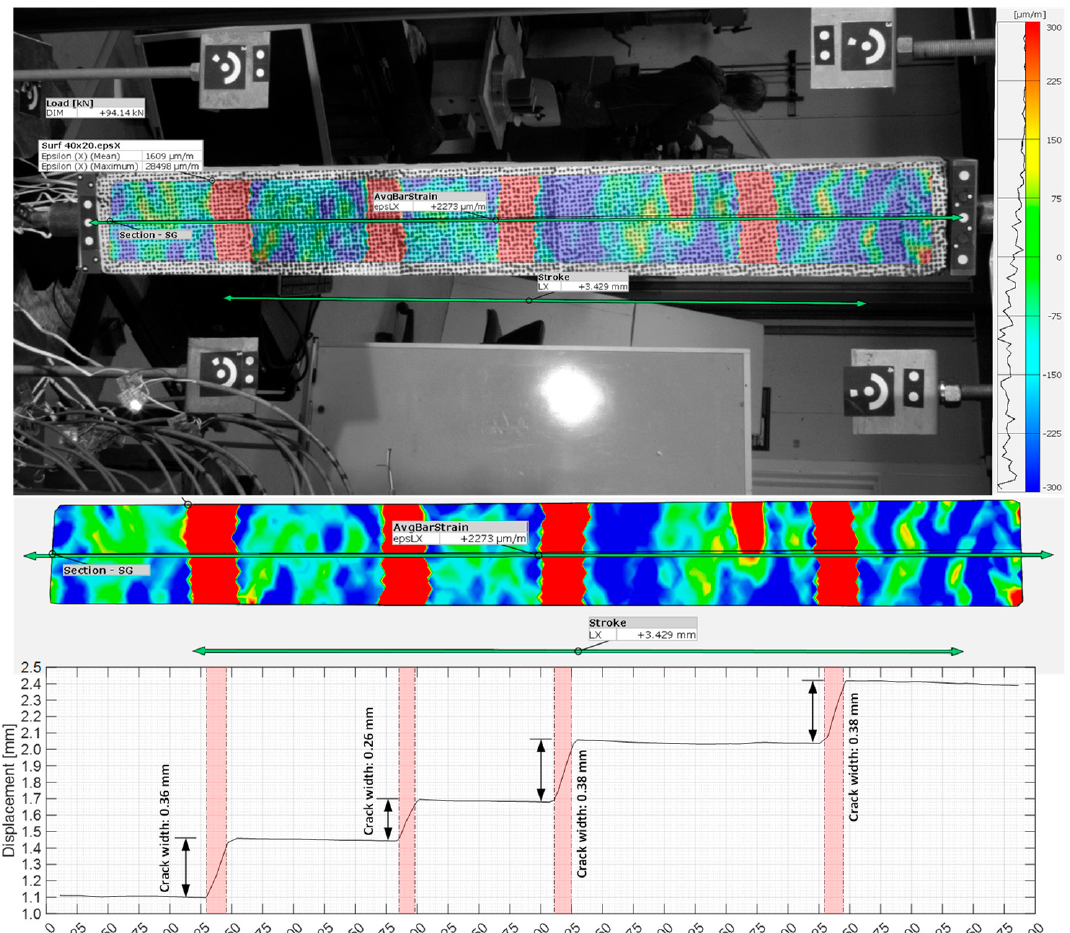
Figure 9. Monitored surface strain and displacement on sample 2N100 under 94.14 kN tensile load.